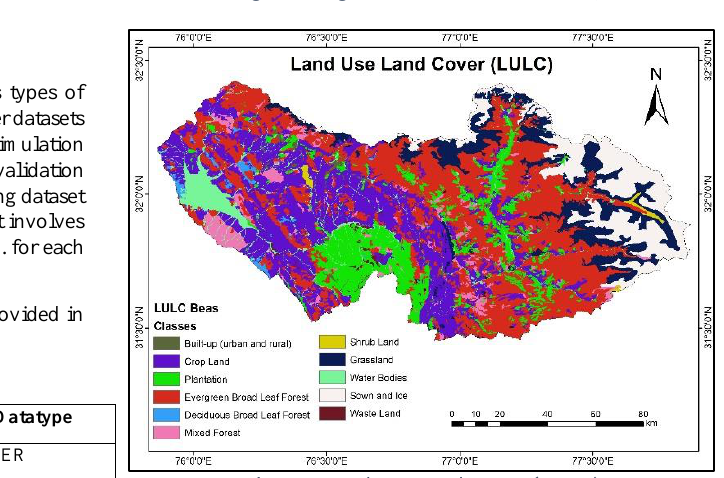
Figure 3 Land Use Land Cover (LULC)